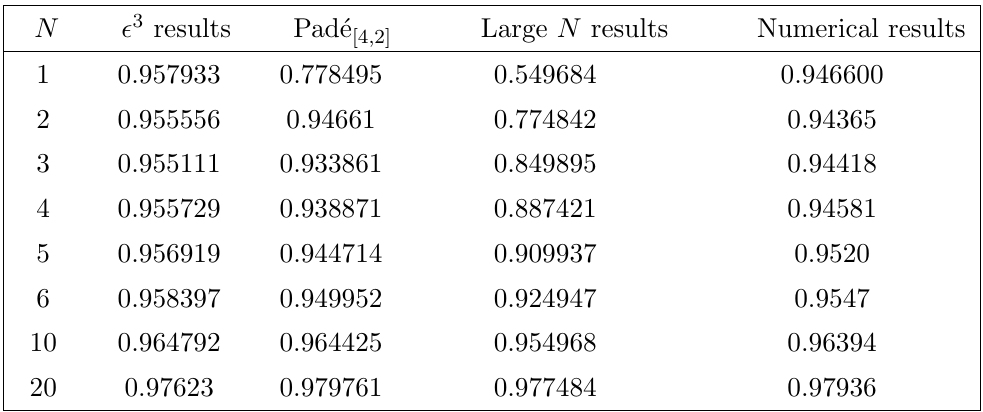
, large N and numerical bootstrap re- [4 ; 2]